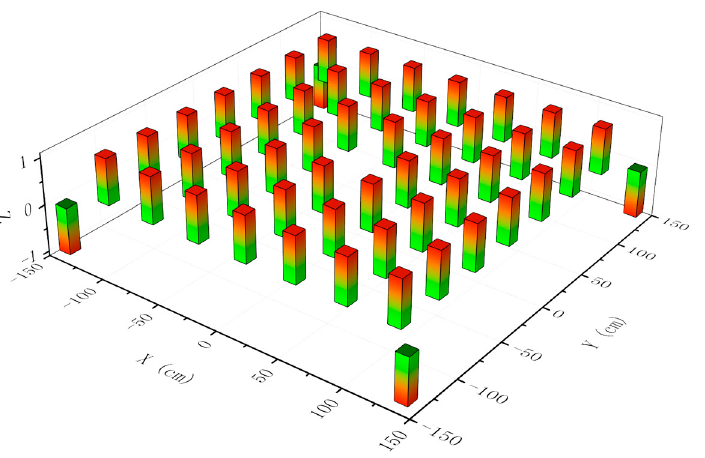
Figure 12. Symmetrical judgement in different positions. The X axis and Y axis represent the real square area, the unit is cm, and the center position is the coordinate origin of the X-Y plane coordinate system. There are two possible values for Z: 1 means a correct judgement in this position while − 1 means false.